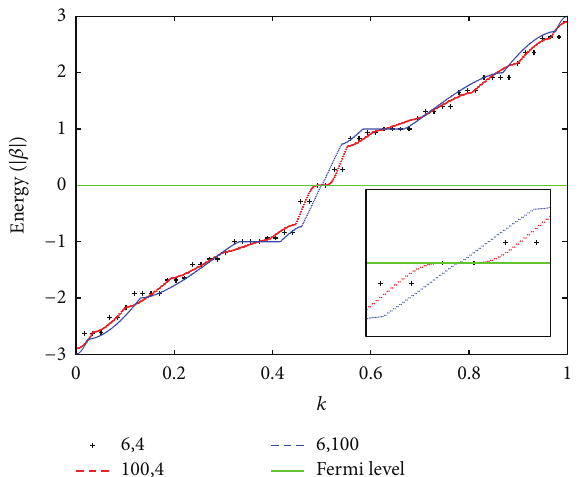
Figure 3: H¨uckel orbital energies for the nanotube (7 4) , where |𝛽| is the energy unit and 𝑘 is the normalized orbital number.